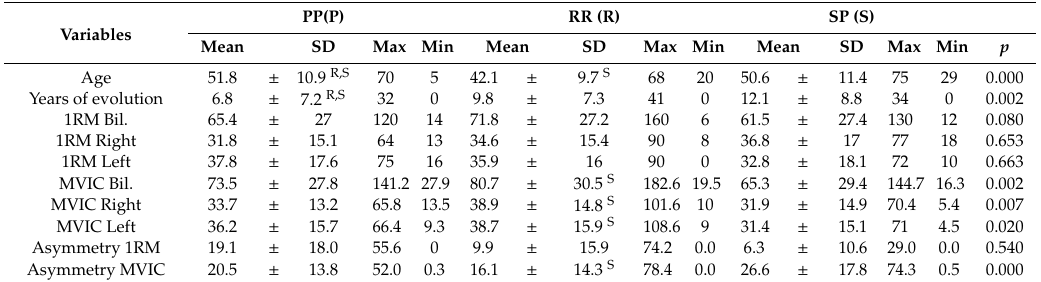
Table 4. Age, years of evolution, and force variables by type of multiple sclerosis.